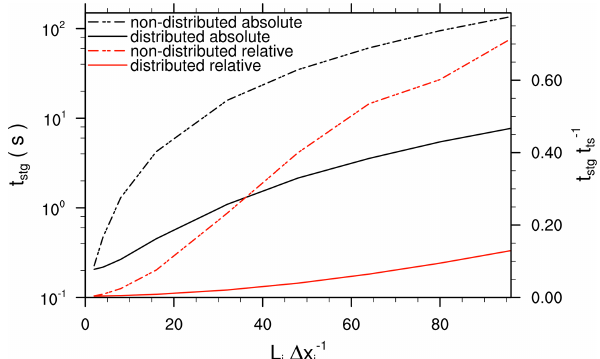
Figure 20. Consumed CPU time by the synthetic turbulence gener- ator for different turbulent length scales. The constantly prescribed length scale is normalized by the isotropic grid spacing. The left or- dinate (black lines) shows the absolute consumed CPU time by the synthetic turbulence generator, while the right ordinate (red lines) shows the relative contribution with respect to the consumed CPU time spent for the time stepping (i.e. without initialization, data out- put, and